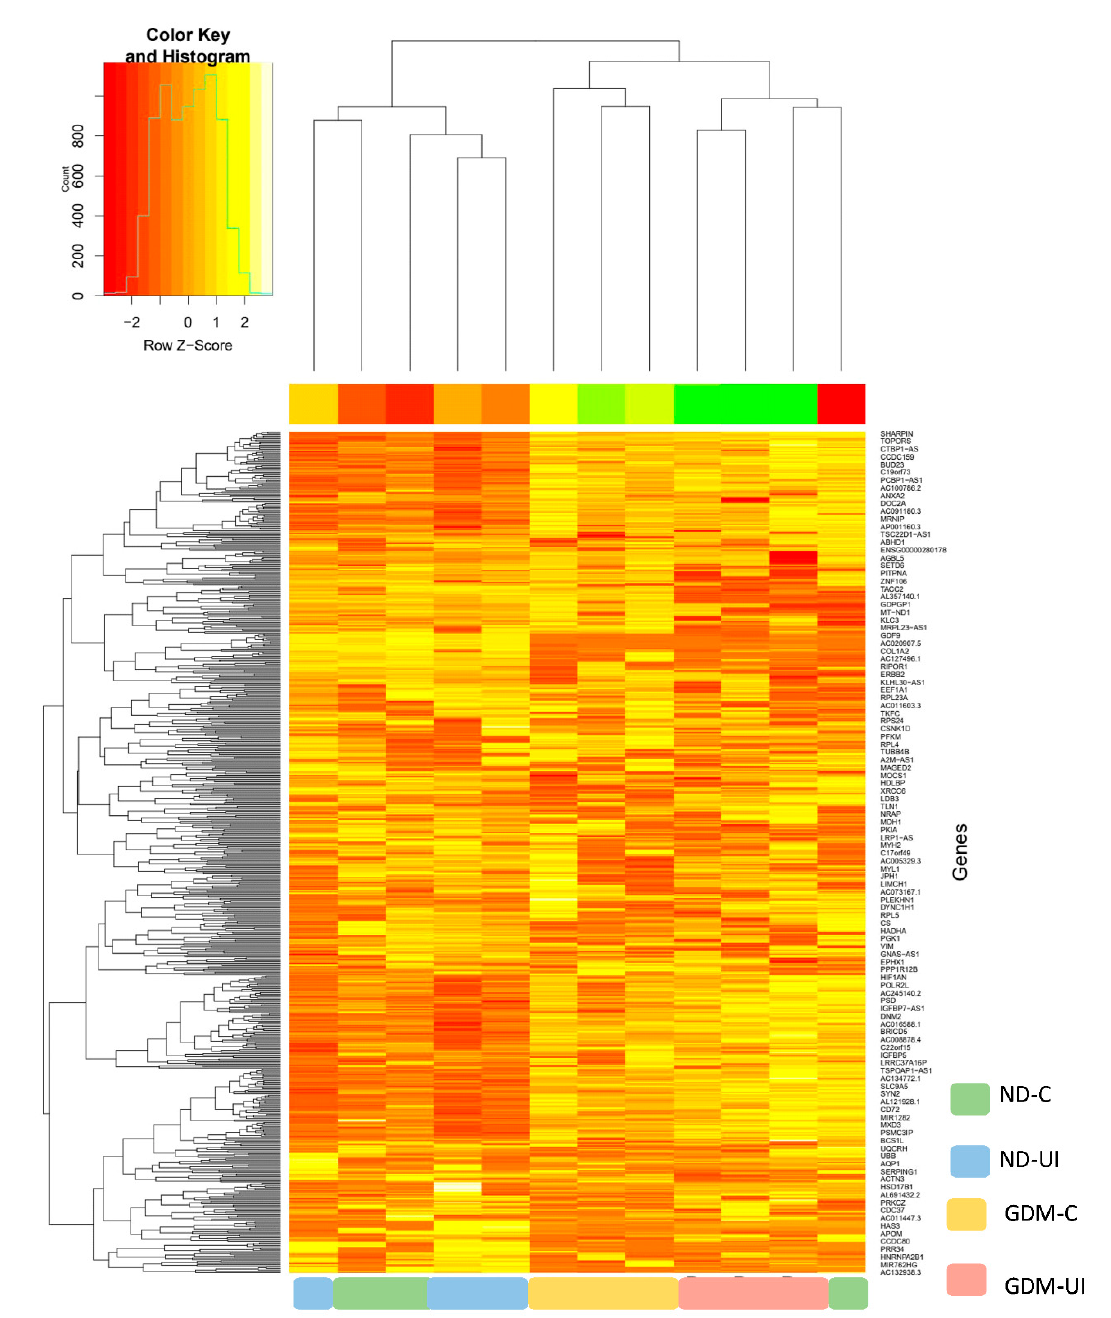
Figure 2. Heatmap showing relative gene expressions. The heat map depicts the relative expressions of each probe set (row) for each woman. The intensity of each block, either yellow (higher expression) or green (lower expression), represents the magnitude of difference from the mean.